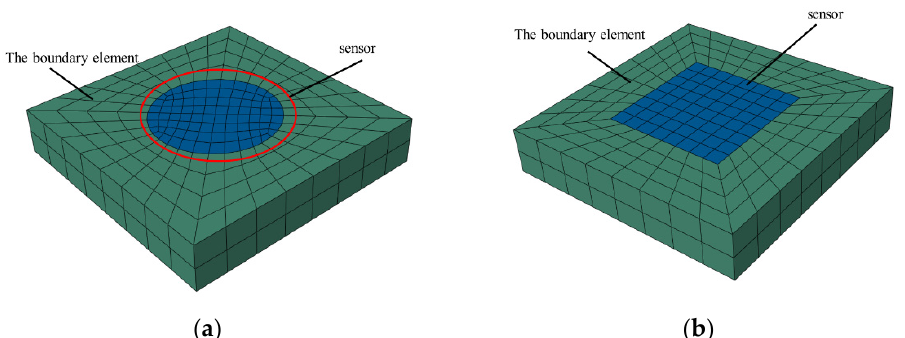
Figure 10. Mesh generation of sensors with different shapes. ( a ) Embedded cylinder sensor; ( b ) em- bedded cuboid sensor.